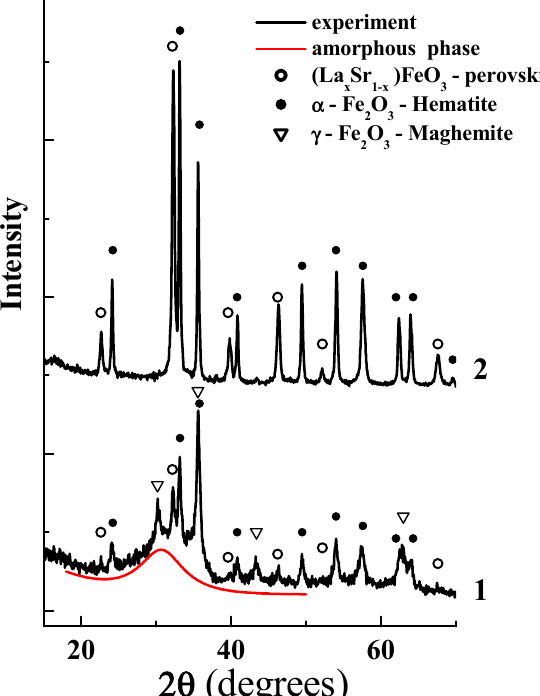
Figure 2. XRD patterns of 30 wt% La 0.8 Sr 0.2 FeO 3 /Fe 2 O 3 after calcination for 3 h at 600 ( 1 ) 700 °C ( 2 ).